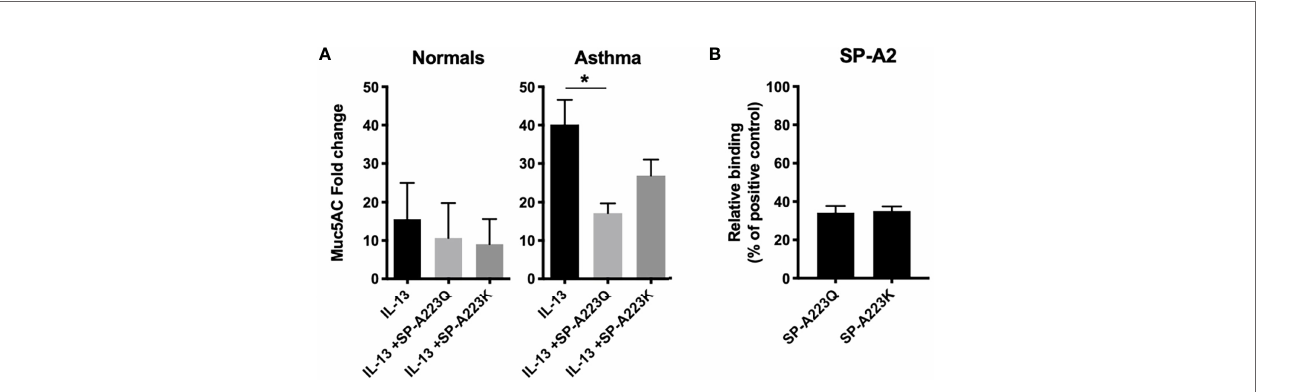
FIGURE 2 | Genetic variation in SP-A2 determines extent of protection against IL-13-induced in fl ammation from bronchial epithelial cells from asthmatic participants. (A) MUC5AC RNA expression from bronchial epithelial cells (n=3 normal, n=3 asthma) grown at ALI and treated with IL-13 for 5 days in the presence of absence of full-length recombinant SP-A2(223K) (20 m g/ml) or SP-A2(223Q) (20 m g/ml) that were added 30 min prior to challenge. After standardization to the housekeeper gene, data are displayed as fold relative to the non-IL-13 challenged control for each respective patient set, with the standard deviation shown. Average fold change and standard deviation are displayed. *p < 0.05. (B) Genetic variants of SP-A2 that differ only at position 223 (Q and K) were examined for relative binding to IL-13 relative to extracted human oligomeric control